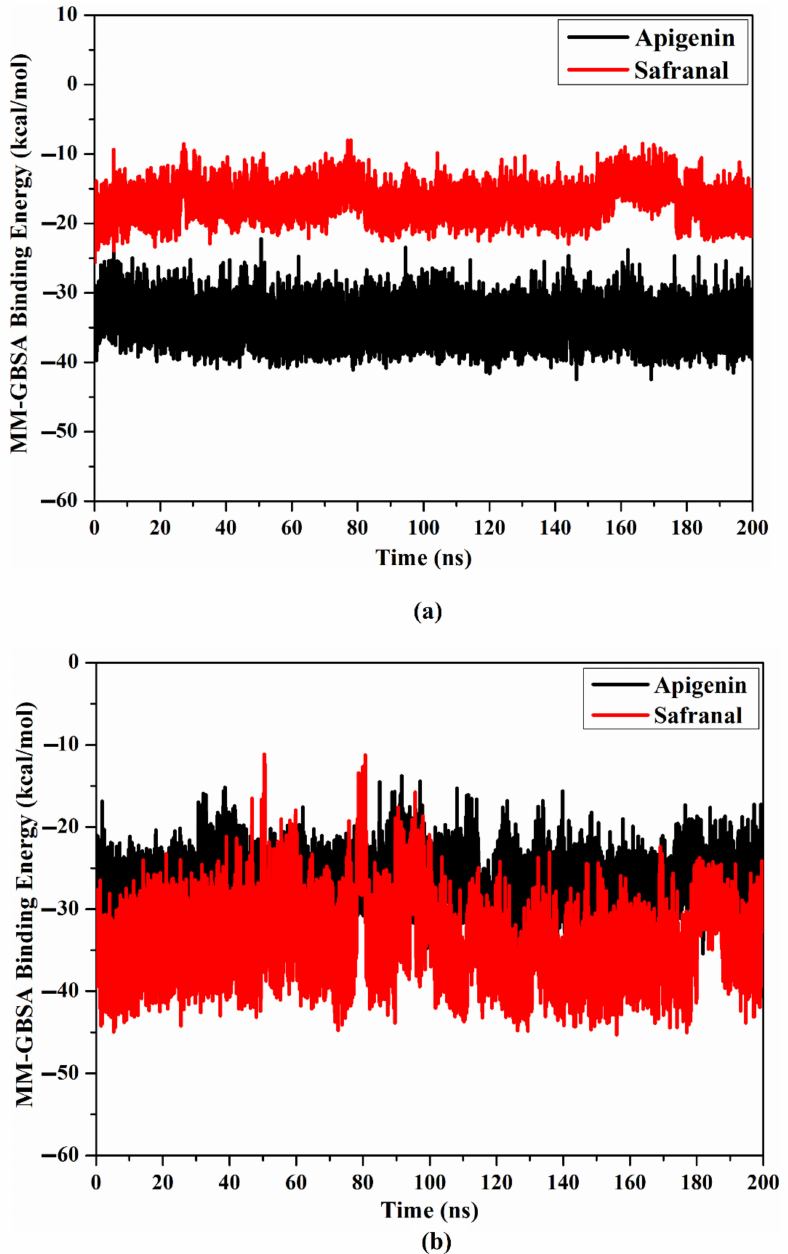
Figure 7. Evaluated binding affinity per frame for apigenin (in black) and safranal (in red) with the ( a ) 5HT2AR and ( b ) 5HT1AR throughout 200ns MD